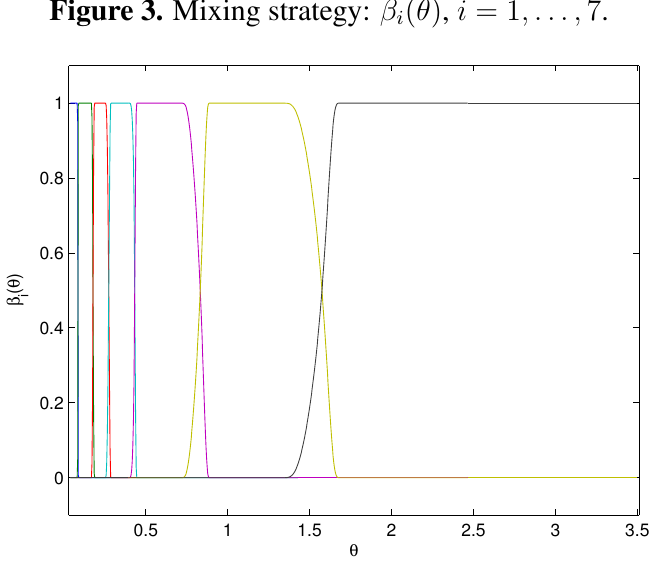
Figure 3. Mixing strategy: β